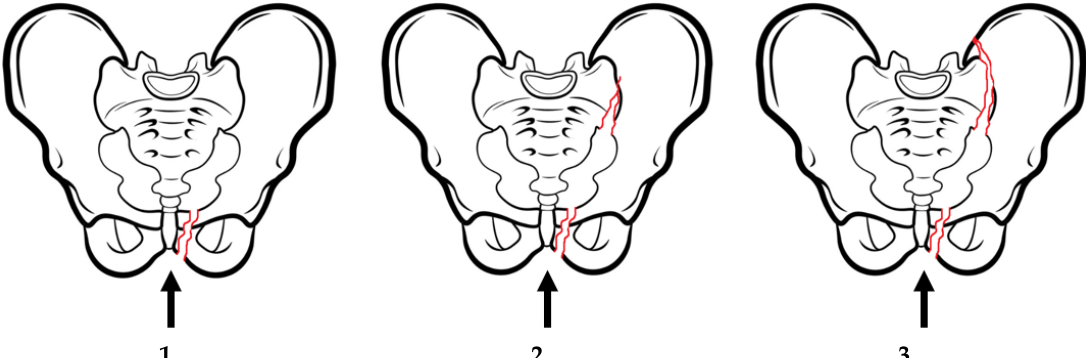
Figure 2. Pelvic fractures caused as a result of front-back injuries (pelvis front-back compression). Own study based on [12].